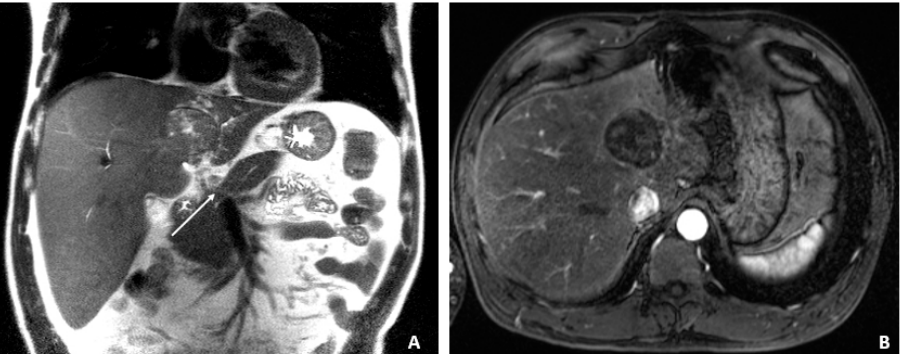
Figure 1. MRI at the time of diagnosis of HCC (December 2009). ( A ) The coronal T2-weighted image shows a mildly heterogeneous mass in the left hepatic lobe (arrow), corresponding to hepatocellular carcinoma. ( B ) The axial T1-weighted fat-suppressed arterial-phase postcontrast image shows faint foci of hyperenhancement within the lesion, characteristic of HCC.